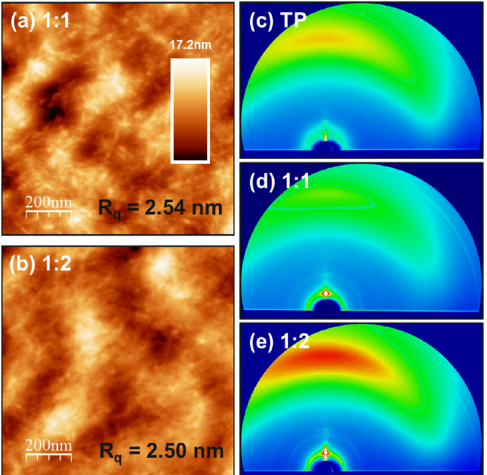
Figure 2. AFM images (1 µm × 1 µm) of PffBT4T-2OD:TP blends films of ( a ) 1:1 and ( b ) 1:2 weight ratio in tapping mode. 2D GIWAXS pattern of ( c ) neat TP, ( d ) 1:1, and ( e ) 1:2 blend films. (R q is the root mean square roughness).